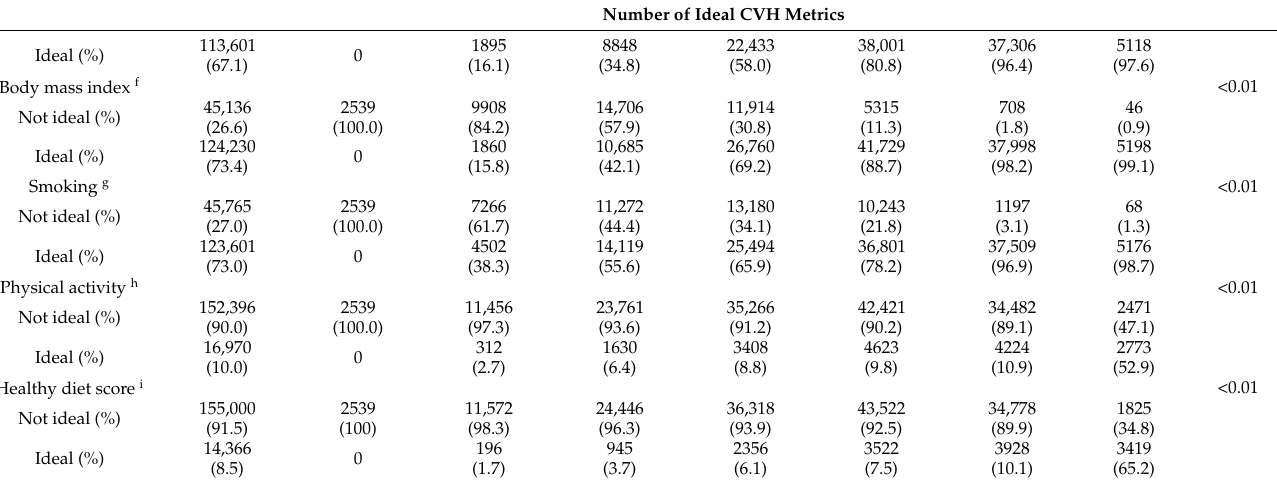
Number of Ideal CVH